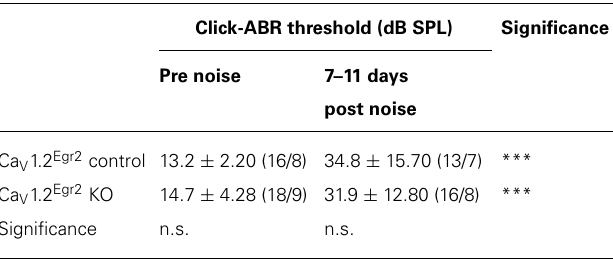
Table 2 |Auditory brainstem response thresholds for Ca V 1.2 Egr2 mouse line evoked by click stimuli. Click-ABR threshold (dB SPL)